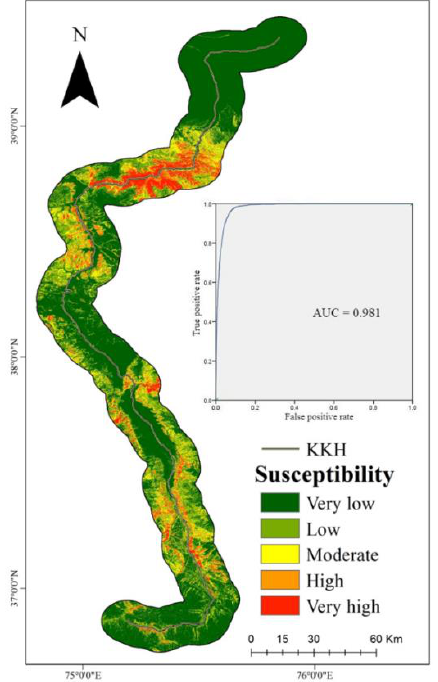
Figure 6. Landslide susceptibility map of KKH and the related ROC curve using the Random Forest model.